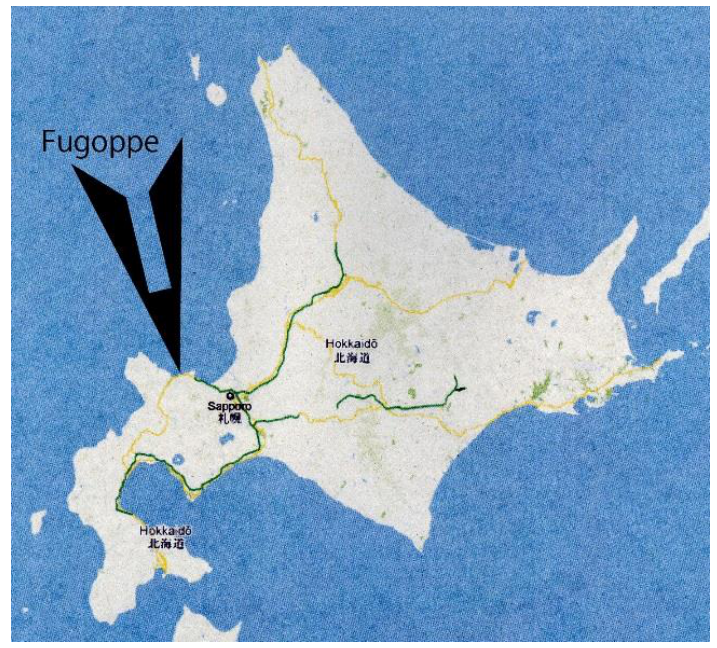
Figure 1. Map of Hokkaido, indicating Fugoppe Cave.